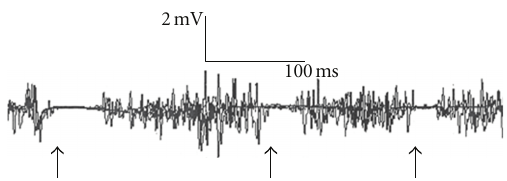
Figure 1: Example of multiple recurrent CSPs observed in subjects with RLS. Figure 1 demonstrates an inhibitory response of a subject with RLS. After TMS on the nondominant hemisphere of this RLS subject 3 separate CSPs in the nondominant ADM (arrows pointing to the suppression of muscle activity) could be